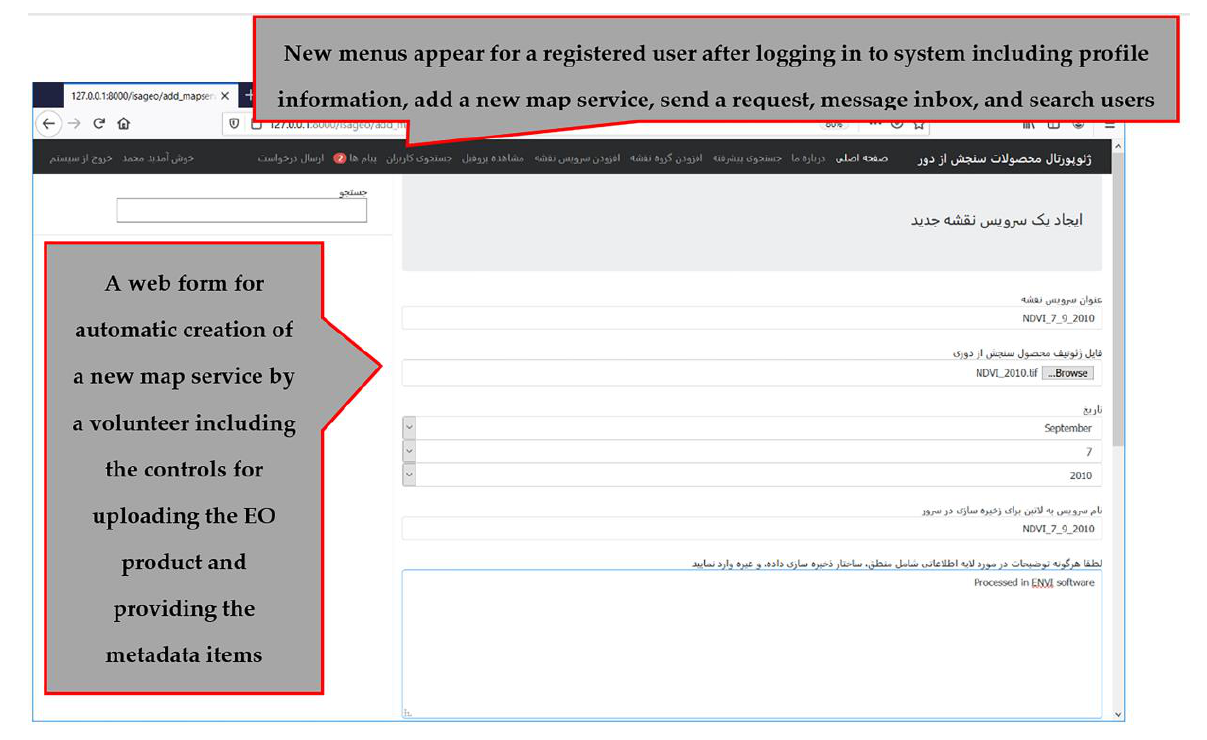
Figure 10. A web form for publishing a new EO product service by a volunteer.